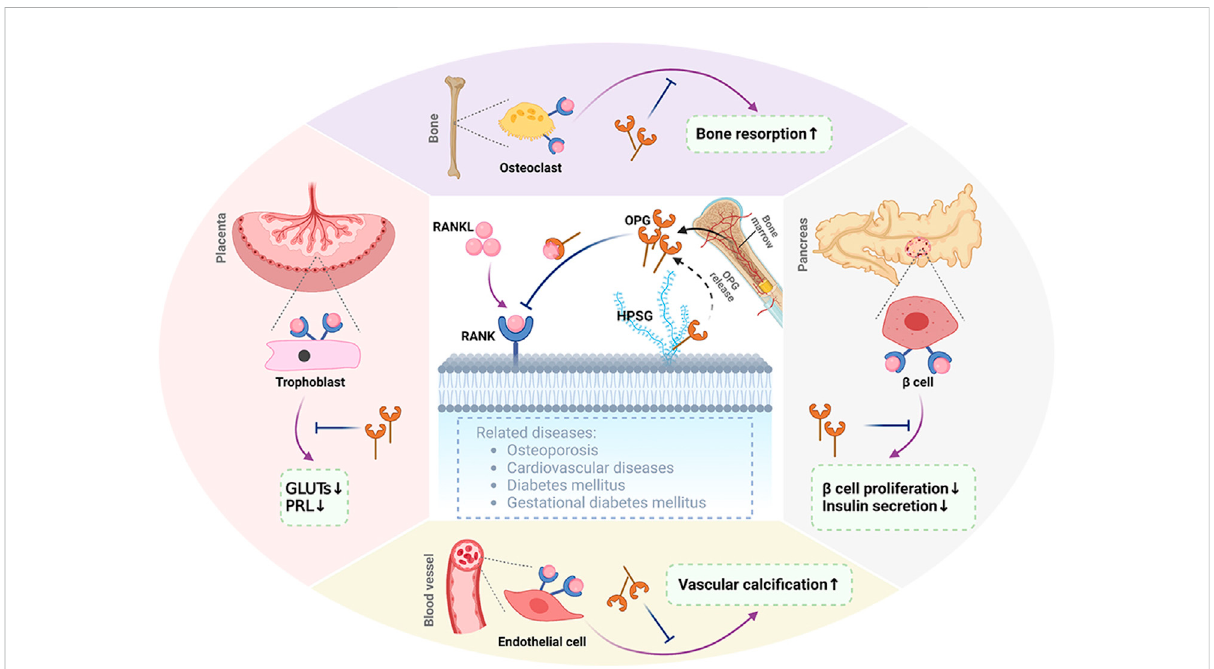
FIGURE 1 RepresentationofRANKL/RANK/OPG.RANKLbindstoitsreceptorRANK,whichcanbefoundinmembrane-boundmoleculesinvolvedinbone resorption in osteoclasts, decreasing GLUT and PRL expression levels in the placenta, vascular calci fi cation in blood vessels, and inhibiting β -cell proliferation and insulinsecretion inislets. Osteoprotegerin(OPG),as adecoyreceptorfor RANKL,issecreted bythebonemarrow andasasecreted glycoprotein. OPG competitively binds to RANKL to inhibit some functions of RANKL/RANK signaling in the bone, placenta, blood vessels, and pancreas. In addition, OPG binds to glycosaminoglycans such as heparin sulfate proteoglycans (HSPGs). OPG, osteoprotegerin; RANK, receptor activator of nuclear factor kappa-B; RANKL, receptor activator of nuclear factor kappa-B ligand; GLUTs, glucose transport proteins; PRL, prolactin. The fi gure was created with